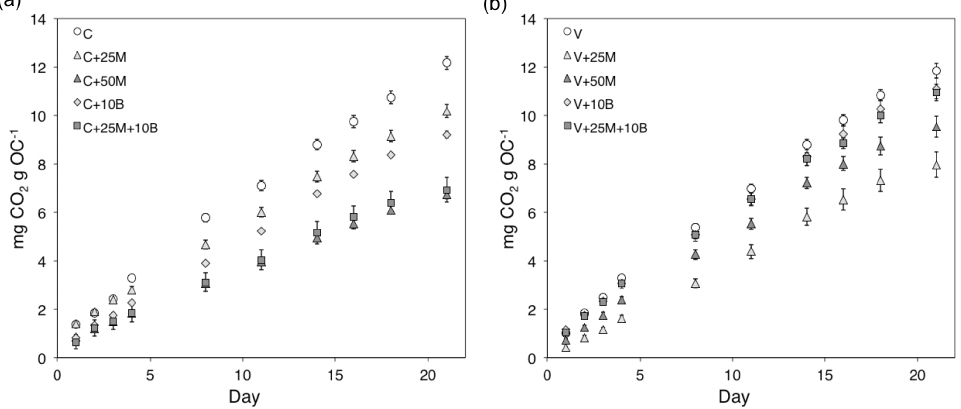
Figure 2. (a) Cumulative CO 2 emissions during composting without worms of pre-composted material alone (C), with 25% clay (C + 25M), with 50% clay (C + 50M), with 10% biochar (C + 10B) or with 25% clay and 10% biochar (C + 25M + 10B). (b) Cumulative CO 2 emissions during composting with worms of pre-composted material alone (V), with 25% clay (V + 25M), with 50% clay (V + 50M), with 10% biochar (V + 10B) or with 25% clay and 10% biochar (V + 25M + 10B). Bars represent twice the standard deviation of the mean ( n = 4).